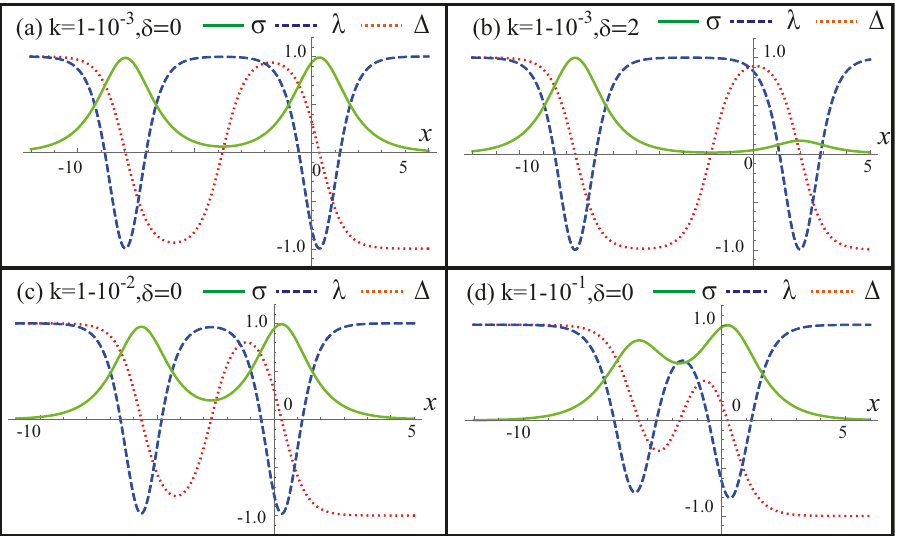
Figure 3 . The two bright soliton con(cid:12)guration of (cid:27) (solid line) and (cid:21) (dashed line). The auxiliary (cid:12)eld (cid:1) (dotted line) are also plotted. Here we set, m = 1. In (cid:12)gure (a) and (b) we plot the case of (cid:14) = 0 and (cid:14) = 2, respectively, with k = 1 (cid:0) 10 (cid:0) 3 . In (cid:12)gure (c) and (d) we plot the case of k = 1 (cid:0) 10 (cid:0) 2 and k = 1 (cid:0) 10 (cid:0) 1 , respectively, with (cid:14) = 0. In the (cid:12)gure, we normalize (cid:27) such that the hight of the highest peak is